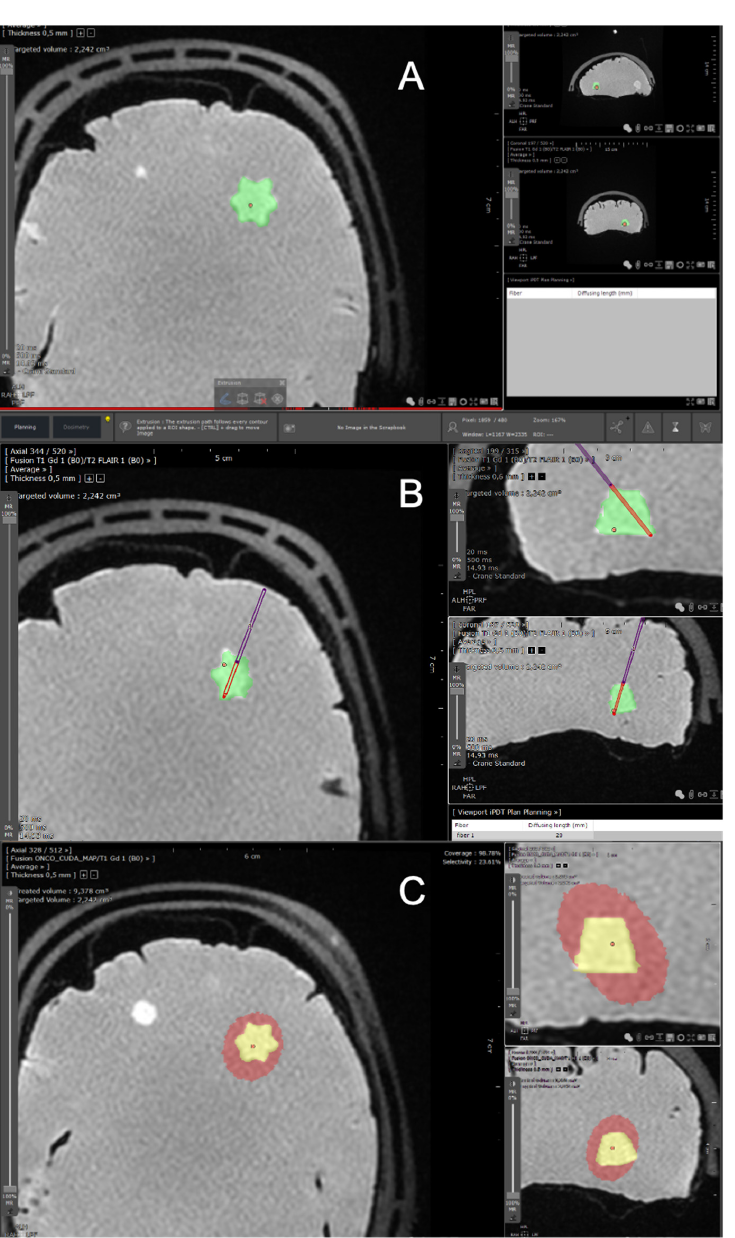
Figure 1. Screenshots from the TPS dedicated to iPDT of GBMs. These screenshots were obtained using a brain phantom (Brain Simulator, Synaptive Resection 750). ( A ) The first step consists of manually contouring the target volume, which is displayed in green (cm 3 ). ( B ) Then, an optical fiber trajectory is defined, with an entry point (point of entry into the skull) and a target point (end of the introduced fiber) harboring stereotactic coordinates. The red portion of the fiber corresponds to the diffusing part. ( C ) The resulting effective volume treated with iPDT is displayed in red. The objective is for the red volume to optimally overlap the target tumor volume in yellow. TPS: treatment planning software. iPDT: interstitial photodynamic therapy. GBMs: